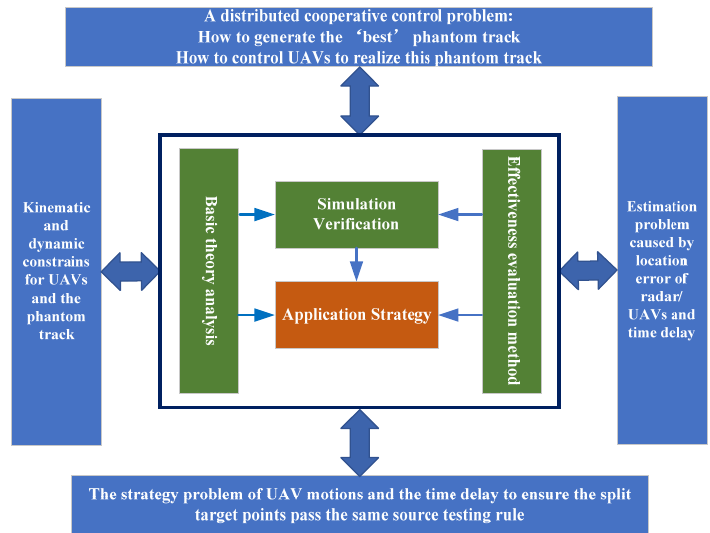
Figure 1. Problem analysis of phantom track deception.